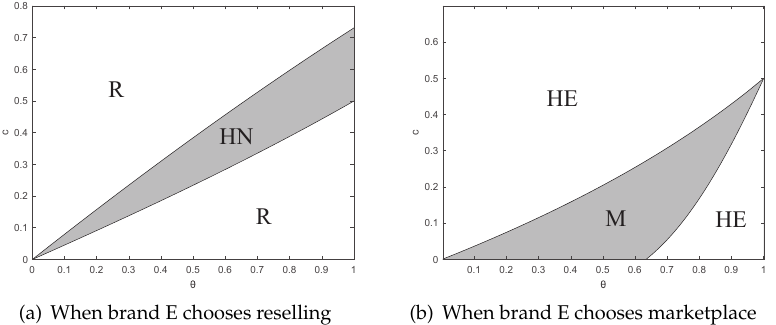
Figure 3. Strategic Selections of Brand